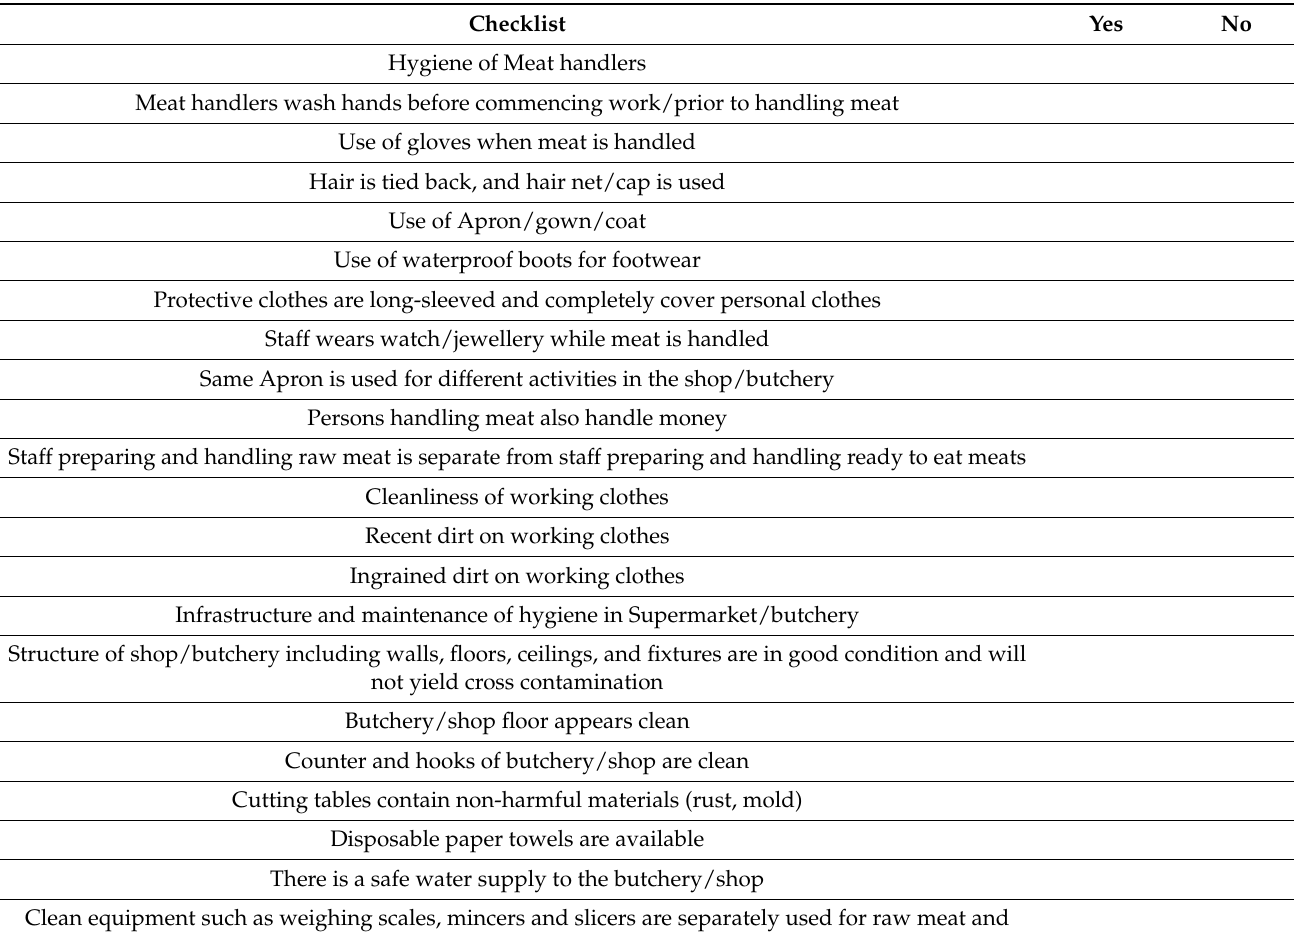
Table 1. Survey checklist to evaluate meat safety practices and hygiene in various butcheries and